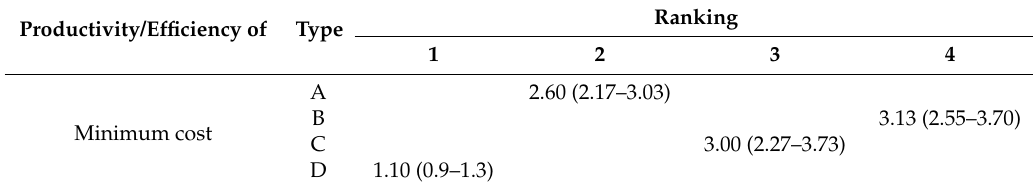
Table 6. Cost ranking of types of scaffolding systems.